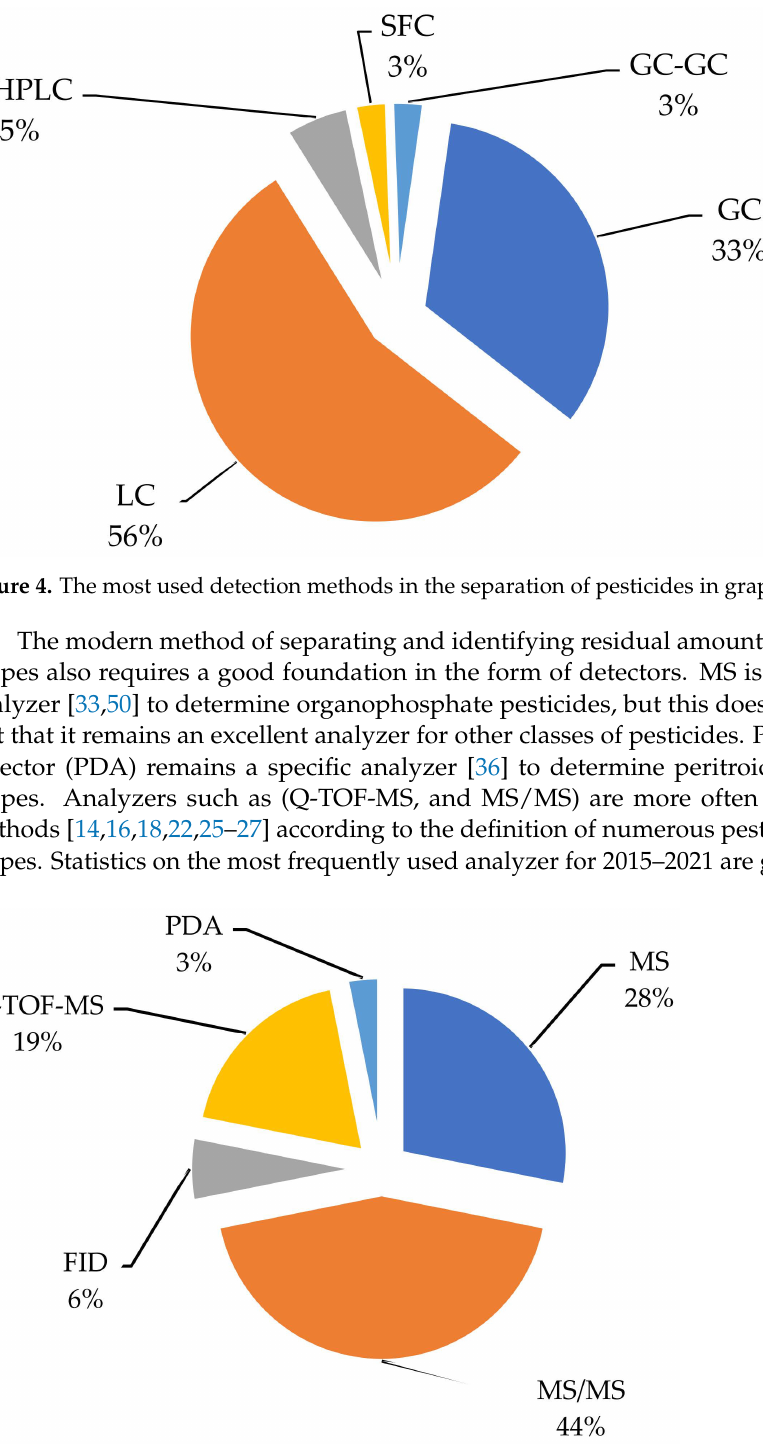
Figure 5. Commonly used detectors in determining the residual amounts of pesticides in